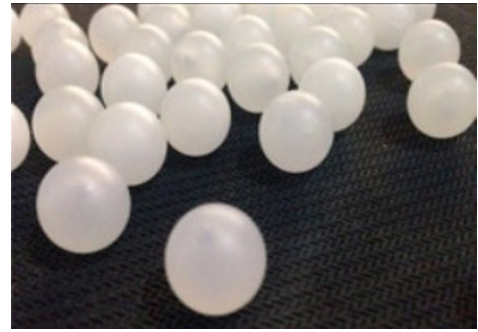
Fig. 7. The precise calibration spheres ”Nylon 6/6